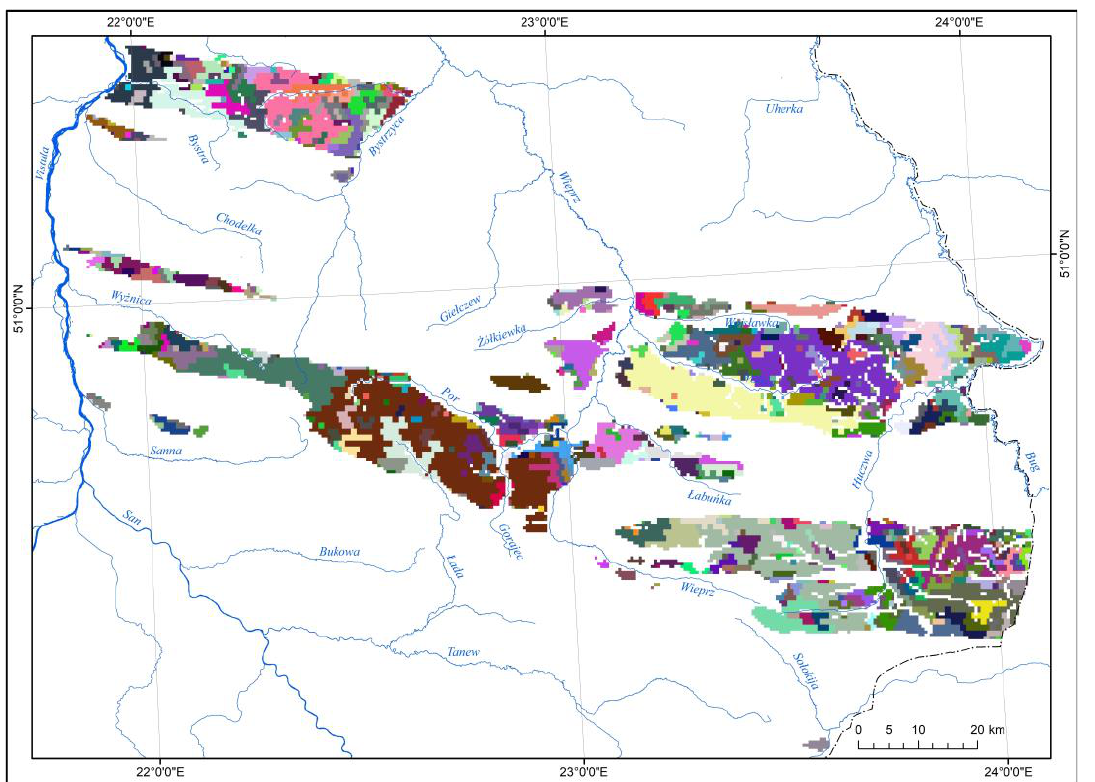
Figure 3. Unique relief segments of analyzed loess patches. Colors represent unique segments.